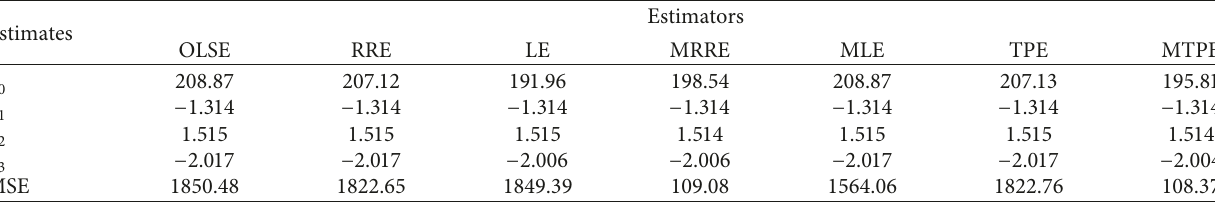
Table 2: Estimated regression coefficients and mean square error of